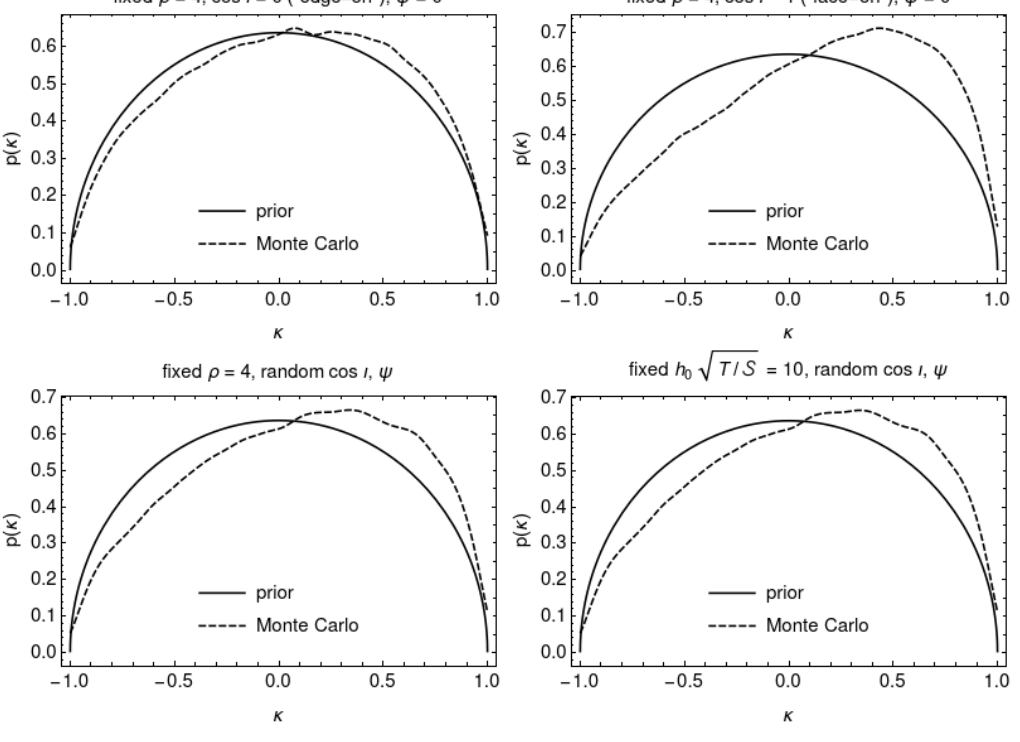
Figure 7. Distribution of κ computed from the Monte-Carlo samples compared to the assumed prior (Equation (18)), for four signal populations (see text). For plotting purposes, the Monte-Carlo curves are smoothed with a Gaussian